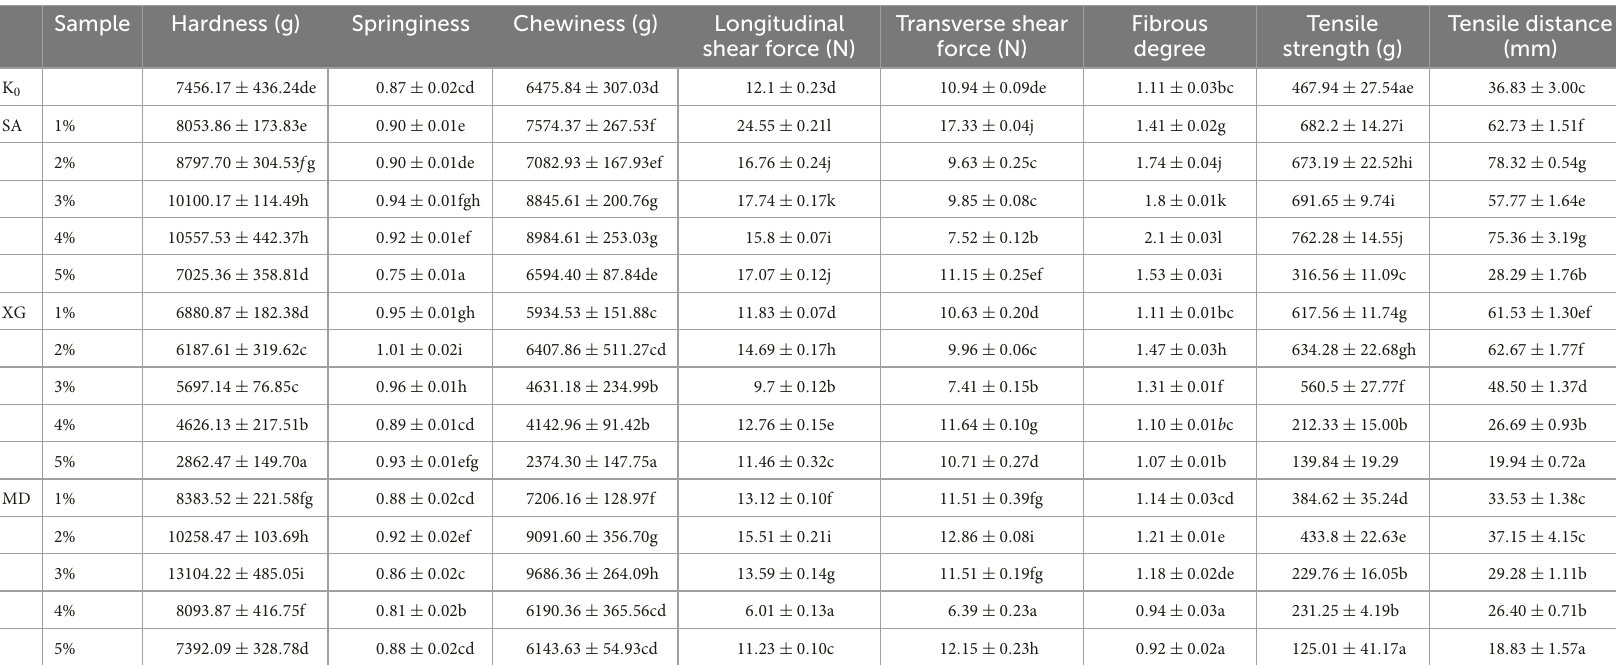
TABLE 1 Texture characteristics, fibrous degree, tensile strength, and tensile distance of SPI-WG extrudates with different